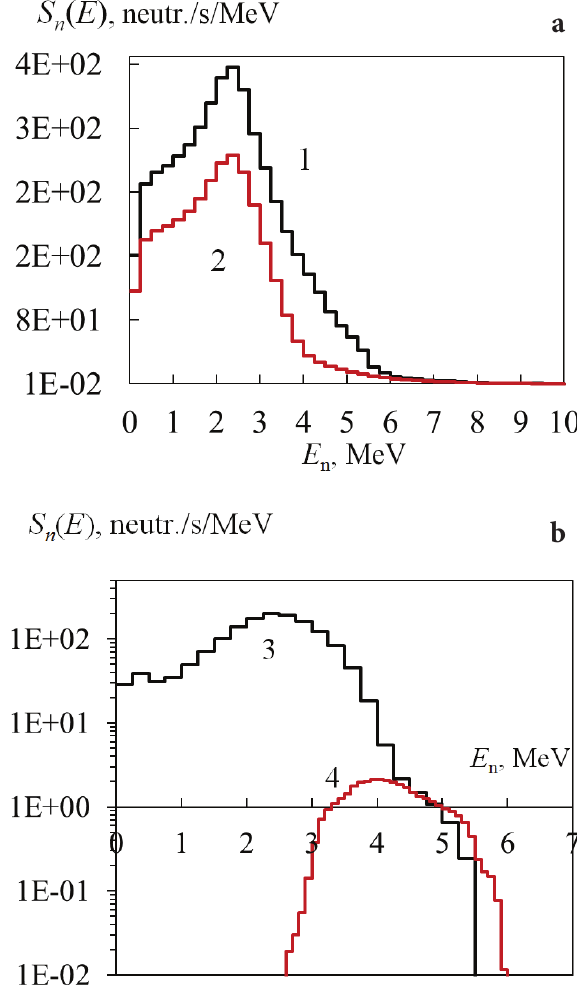
Figure 6. Energy spectrum of the neutron source: 1 – integral yield of neutrons; 2 – yield of neutrons from spontaneous fission and the (α, n) reaction on 17,18 O [(Th,Pu)O trons from to the (α, n) reaction on 17,18 O; 4 – yield of neutrons from the (α, n) reaction on 13 С (RuS).